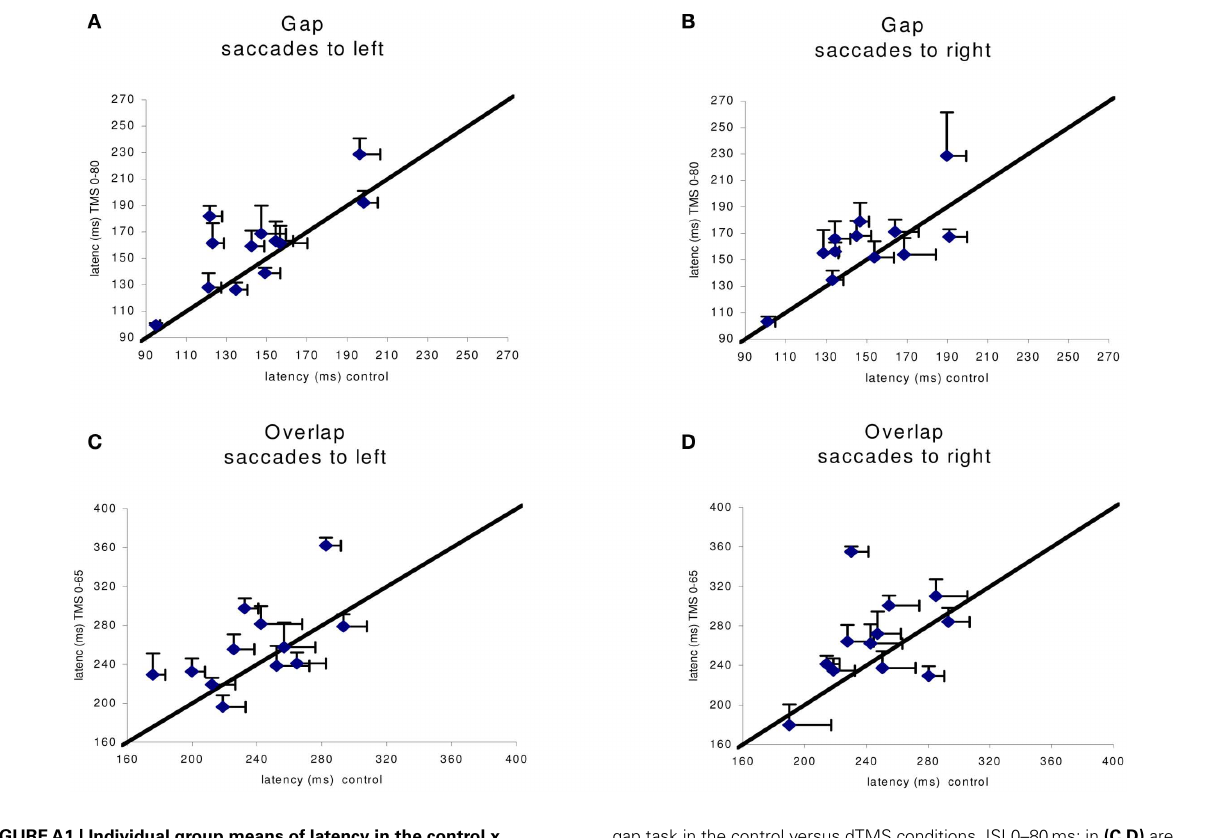
FIGUREA1 | Individual group means of latency in the control x axis) versus dTMS condition with corresponding SE (horizontal, vertical line segment, respectively). In (A,B) are shown data for the